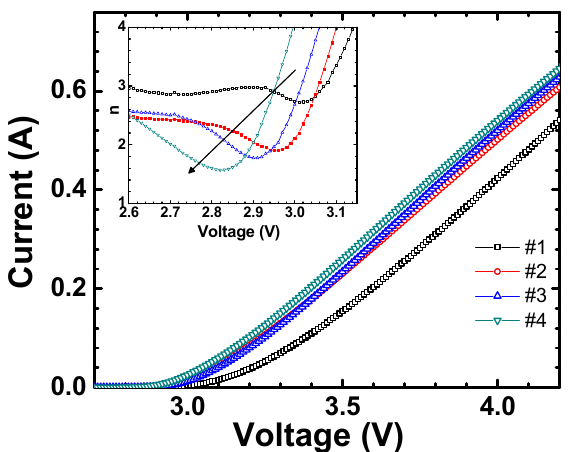
Figure 2. Current-voltage ( I - V ) characteristics of the LED samples. The inset shows the calculated ideality factor ( n ) characteristics.